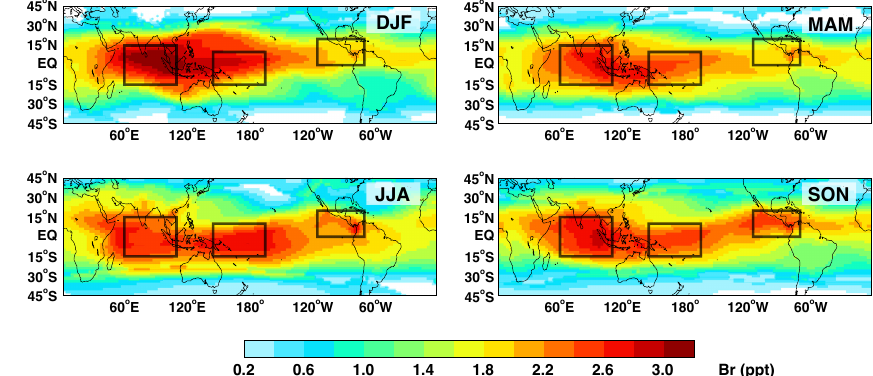
Figure 5. 10-year averaged (2001–2010) seasonal mean distribution of simulated CHBr 3 (unit: ppt Br) at the 355K potential tempera- ture layer (just below the tropopause) in DJF, MAM, JJA, and SON. The black boxes outline the three regions where most of the active troposphere-to-stratosphere transport occurs.